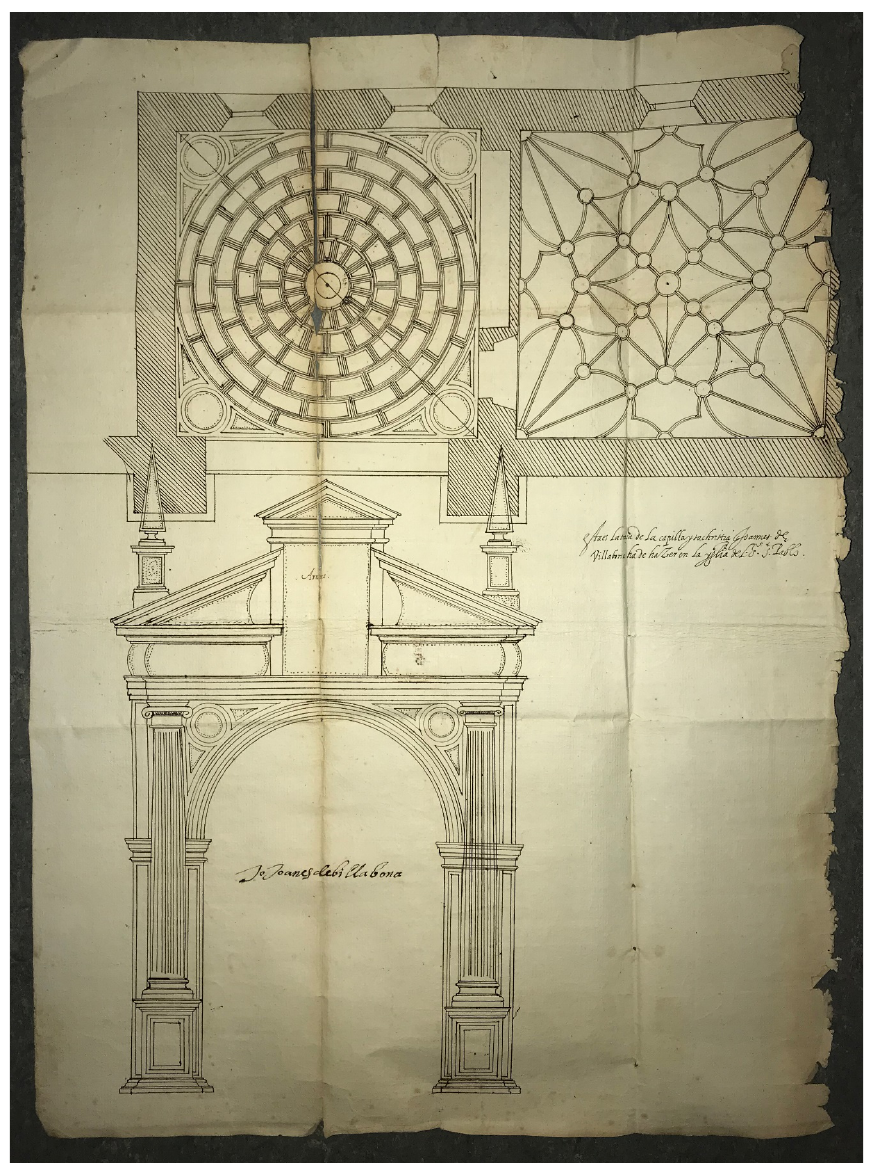
Figure 8. Project for the chapel of Diego Monreal, bishop of Huesca, in the parish church of San Pablo in Zaragoza (A.H.P.N.Z., Fondo de muestras y trazas). © Archivo Histórico de Protocolos Notariales de Zaragoza.